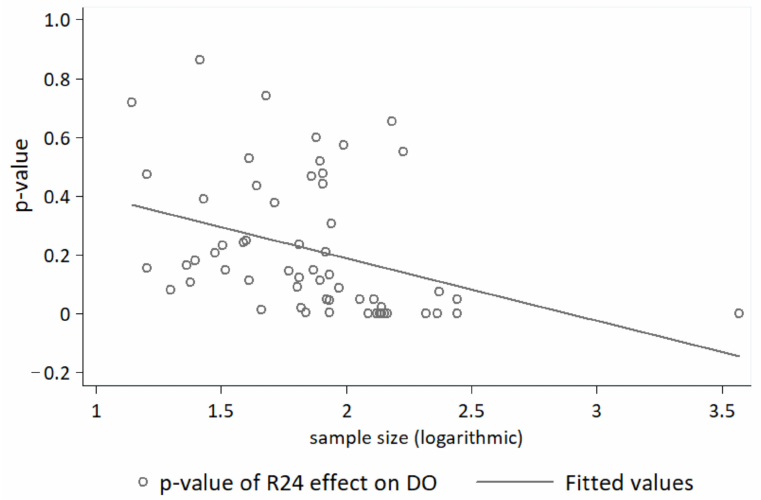
Figure 4. Relationship (scatter plot and fit line) between statistical sample size and R24 p -value of the logistic regression models examining the effect of R24 on DO per